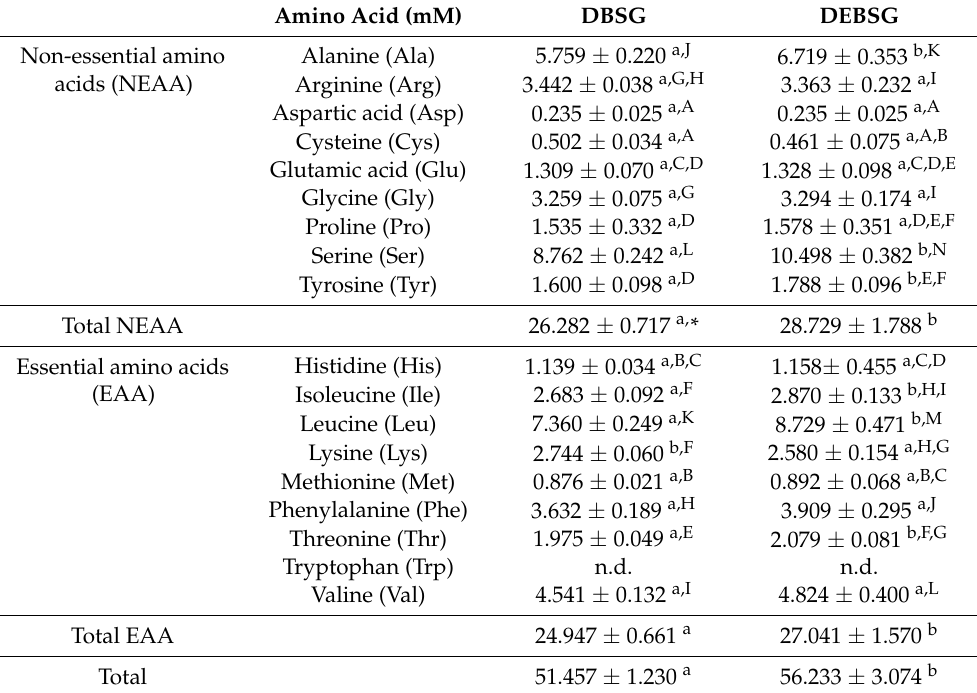
Table 2. Amino acid profile for BSG intestinal digests (DBSG) and EBSG intestinal digests (DEBSG). Amino Acid (mM) Non-essential amino